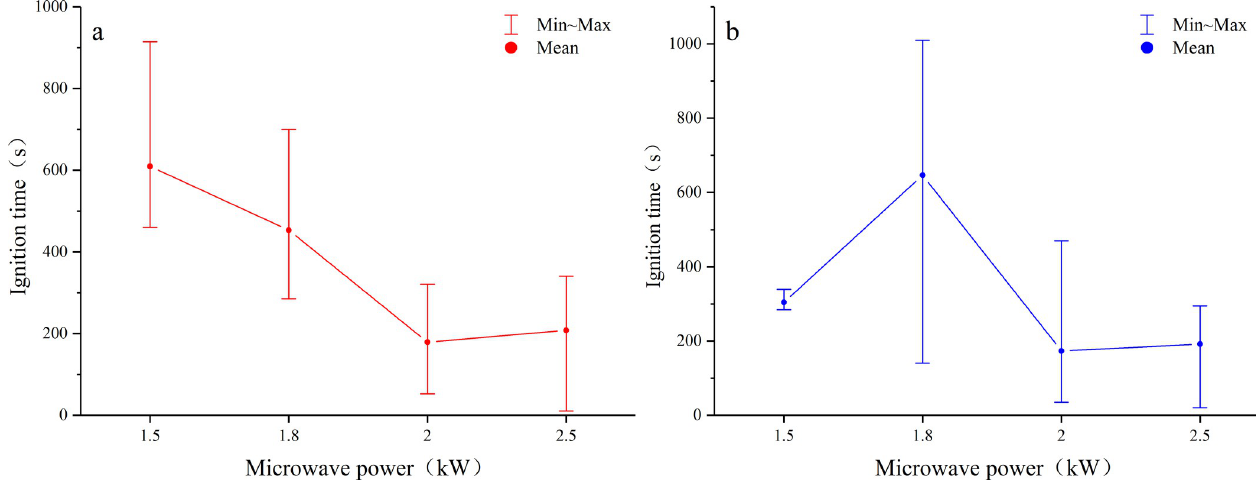
Fig 9. Effects of microwave power on ignition time of coal samples. (a) dry samples, (b) water-saturated samples.